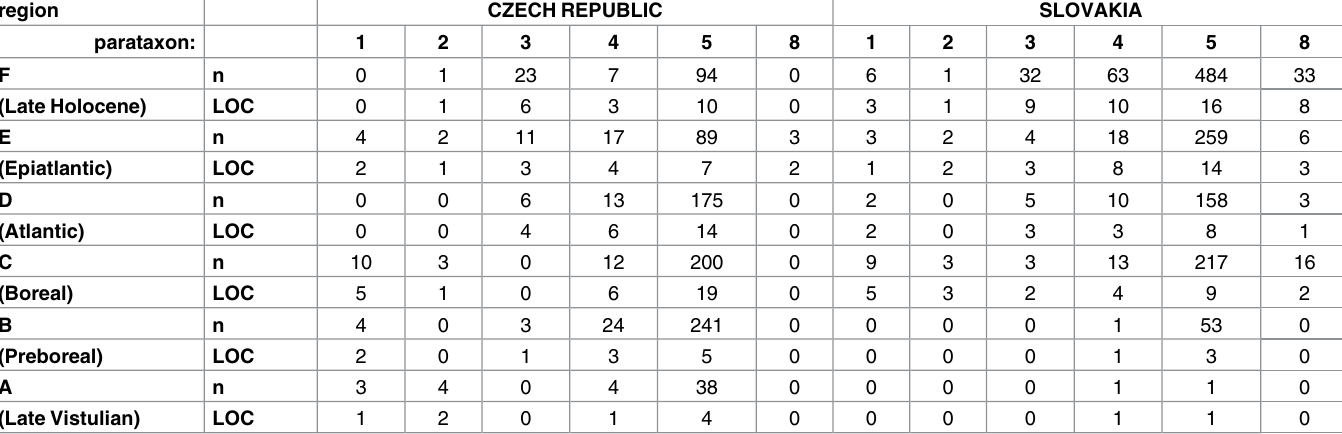
Table 3. Parataxaof Apodemus (1–5, 8) in the Late Pleistocene/Holocene fossil record from particular biostratigraphic horizons (A-F) in the Czech Republic and Slovakia (n-number of molars, LOC-number of community samples). 1 – A . uralensis , 3 – A-sylvaticus , 5 – A flavicollis ,8 – A . agrarius . region